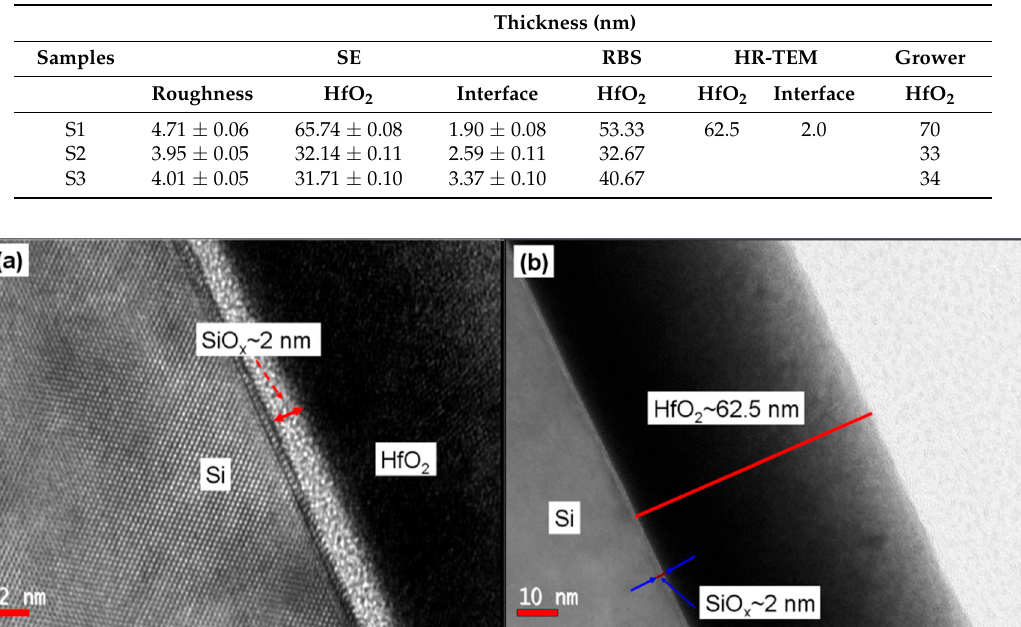
Figure 8. SE spectra (dot lines) and fitted (solid lines) psi and delta spectra vs photon energy with five incident angles (50°, 55°, 60°, 65° and 70°) of HfO 2 /Si sample S3 at RT (300 K). Table 5. The thicknesses of three samples are obtained by VASE, RBS, HR-TEM, and the measured thicknesses from grower.